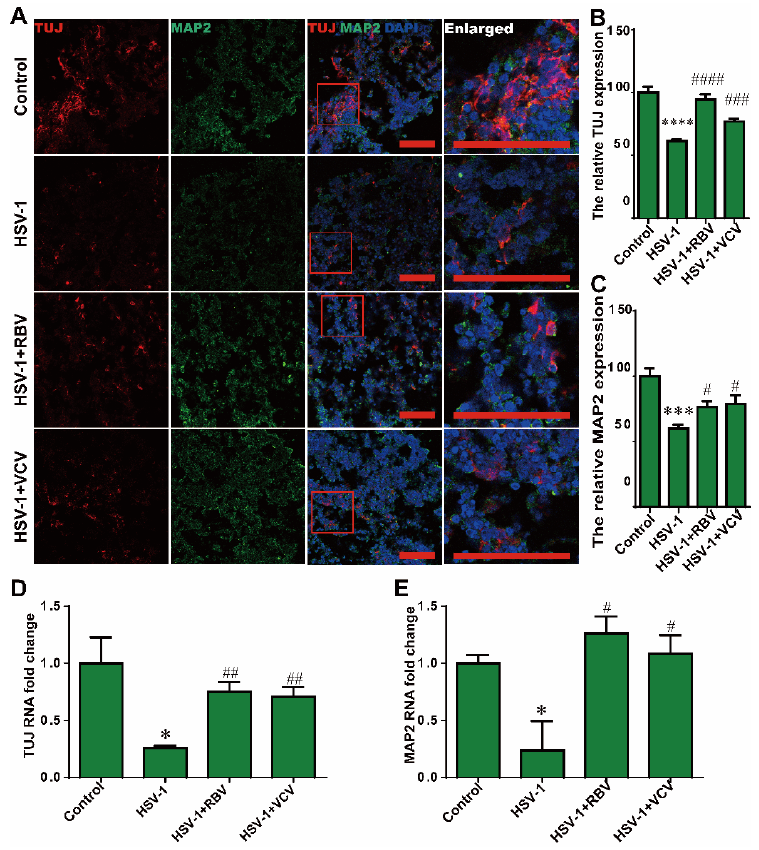
Figure 7. RBV and VCV treatments reduced the neuron loss. ( A ) Co-immunostaining with TUJ and MAP2 in cerebral organoids in the different group at D65 + 3, the red frame line is the position of the enlarged figure. Scale bars (red rectangle): 100 µm. ( B , C ) The relative fluorescence intensity sta- tistics of TUJ and MAP2 expressions in cerebral organoids were shown in different groups at D65 + 3. ( D , E ) The TUJ and MAP2 mRNA expressions were quantified by RT-PCR in the cerebral organ- oids in the different groups at D42 + 3 and D65 + 3. Data represent the mean ± SEM. * p < 0.05 vs. the control group, *** p < 0.005 vs. the control group, **** p < 0.001 vs. the control group, # p < 0.05 vs. the HSV-1 infection group, ## p < 0.01 vs. the HSV-1 infection group, ### p < 0.005 vs. the HSV-1 infection group, #### p < 0.001 vs. the HSV-1 infection group, ( n = 6). 3. Discussion Recently, there are increasing clinical evidence [27] and basic researches [28,29] indi- cating that there is strong correlation linking HSV-1 infection with A β Associated patho- genesis, which supports the AD viral hypothesis [30]. With the limited access to human brain tissue, the further mechanistic verification of this correlation is highly relying on the AD transgenic mouse models [12]. However, HSV-1 is a highly human-specific virus and does not infect the wild type mice in the natural settings [31]. In addition, these transgenic mouse infection models fail to fully capture the human-specific neuropathological fea- tures due to the distinct differences between humans and mice in terms of polarized neu-